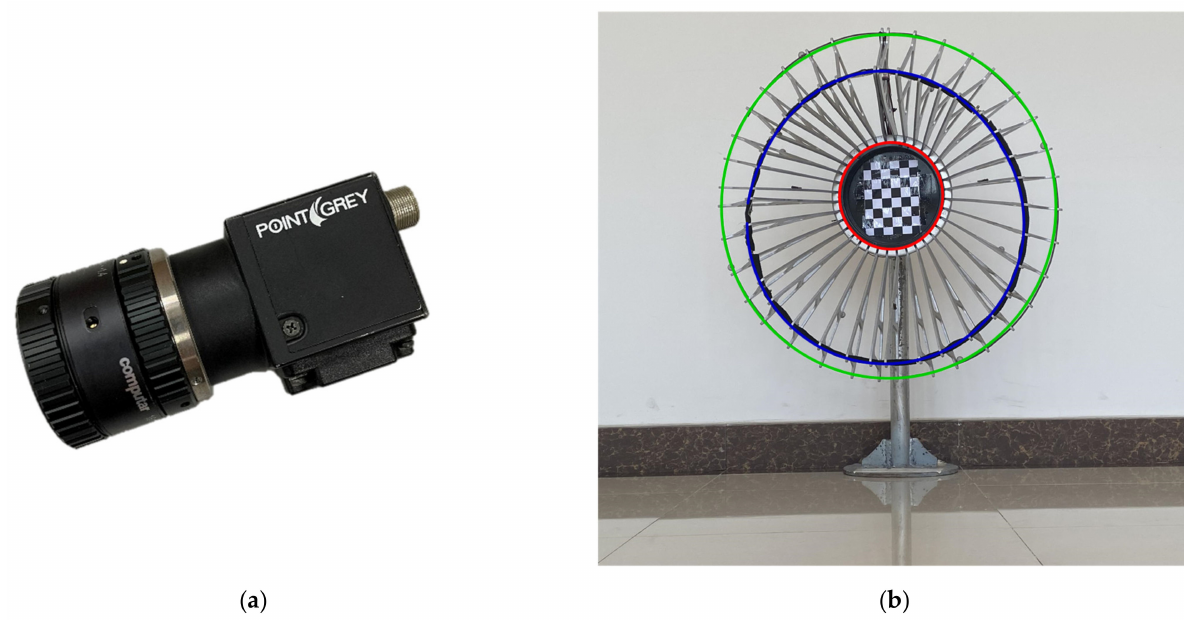
Figure 9. This is a figure about the experimental equipment. ( a ) A photo of the camera and the lens used for image capture. ( b ) A photo of the drogue